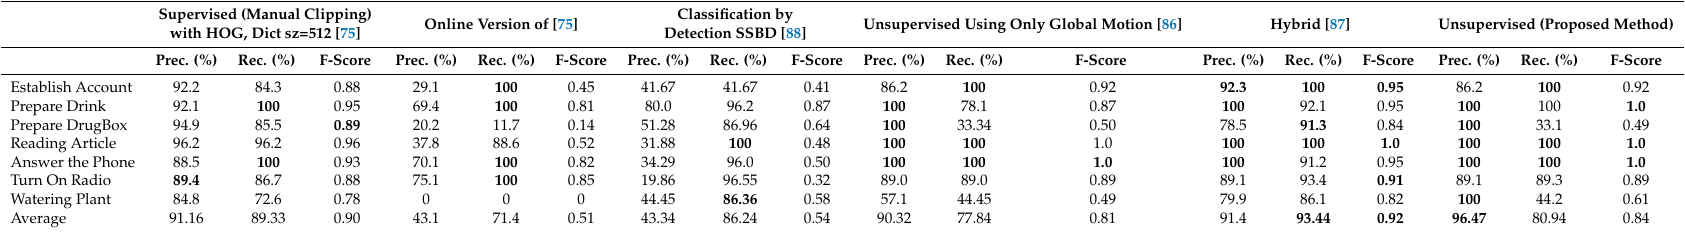
Table 3. Comparison of different recognition frameworks with ours on the GAADRD dataset. The diagram shows the class-wise accuracy of each method with respect to their F-Score values. The best results in each section are indicated in bold.